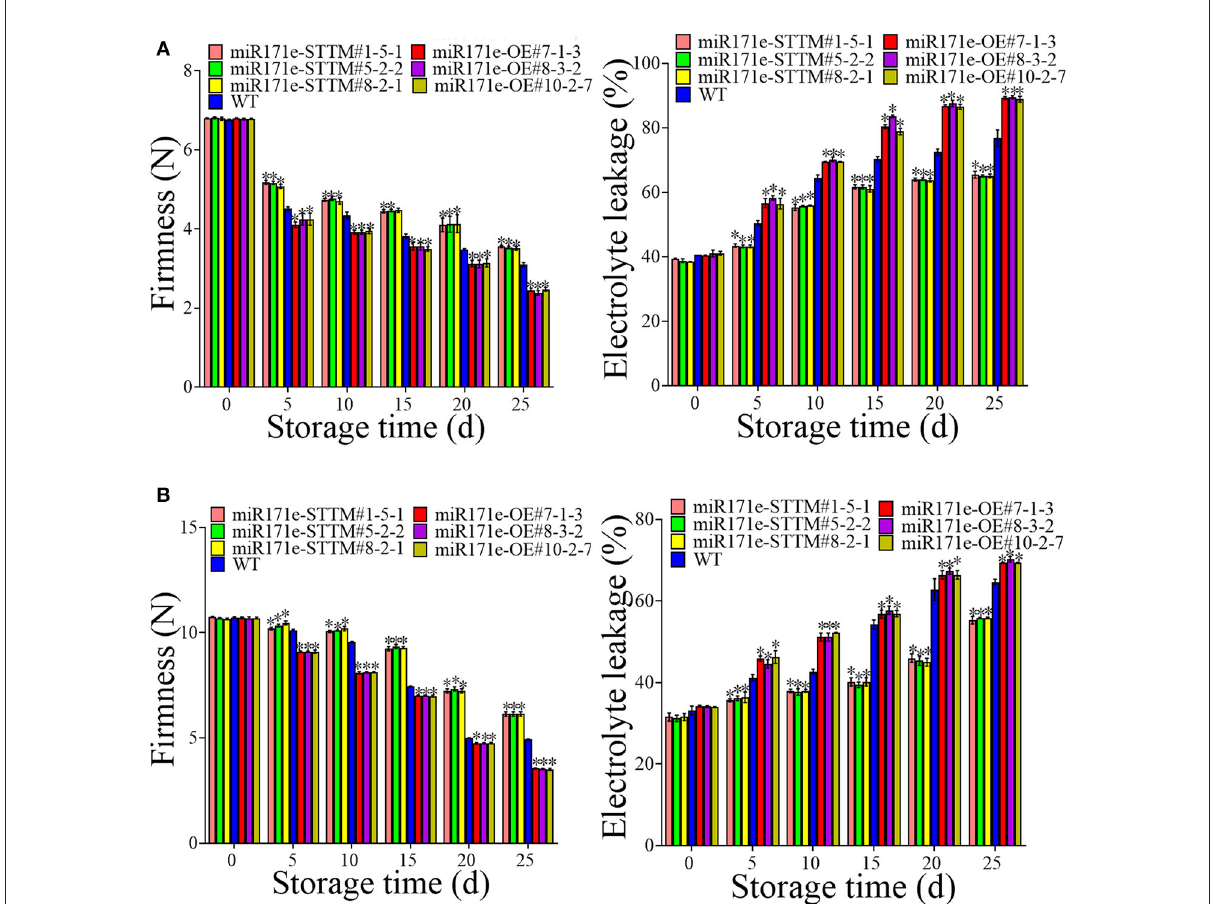
FIGURE3 Electrolyte leakage and firmness in tomato fruit at MR (A) and MG stage (B) . Vertical bars represent standard deviations of the means, n = 3. Asterisks indicate the statistical difference in the significance at * p < 0.05.